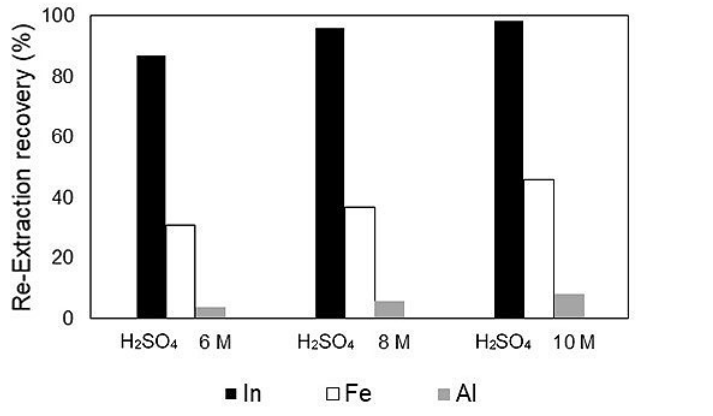
Figure 9. Influence of the concentration of H 2 SO 4 on the re-extraction of